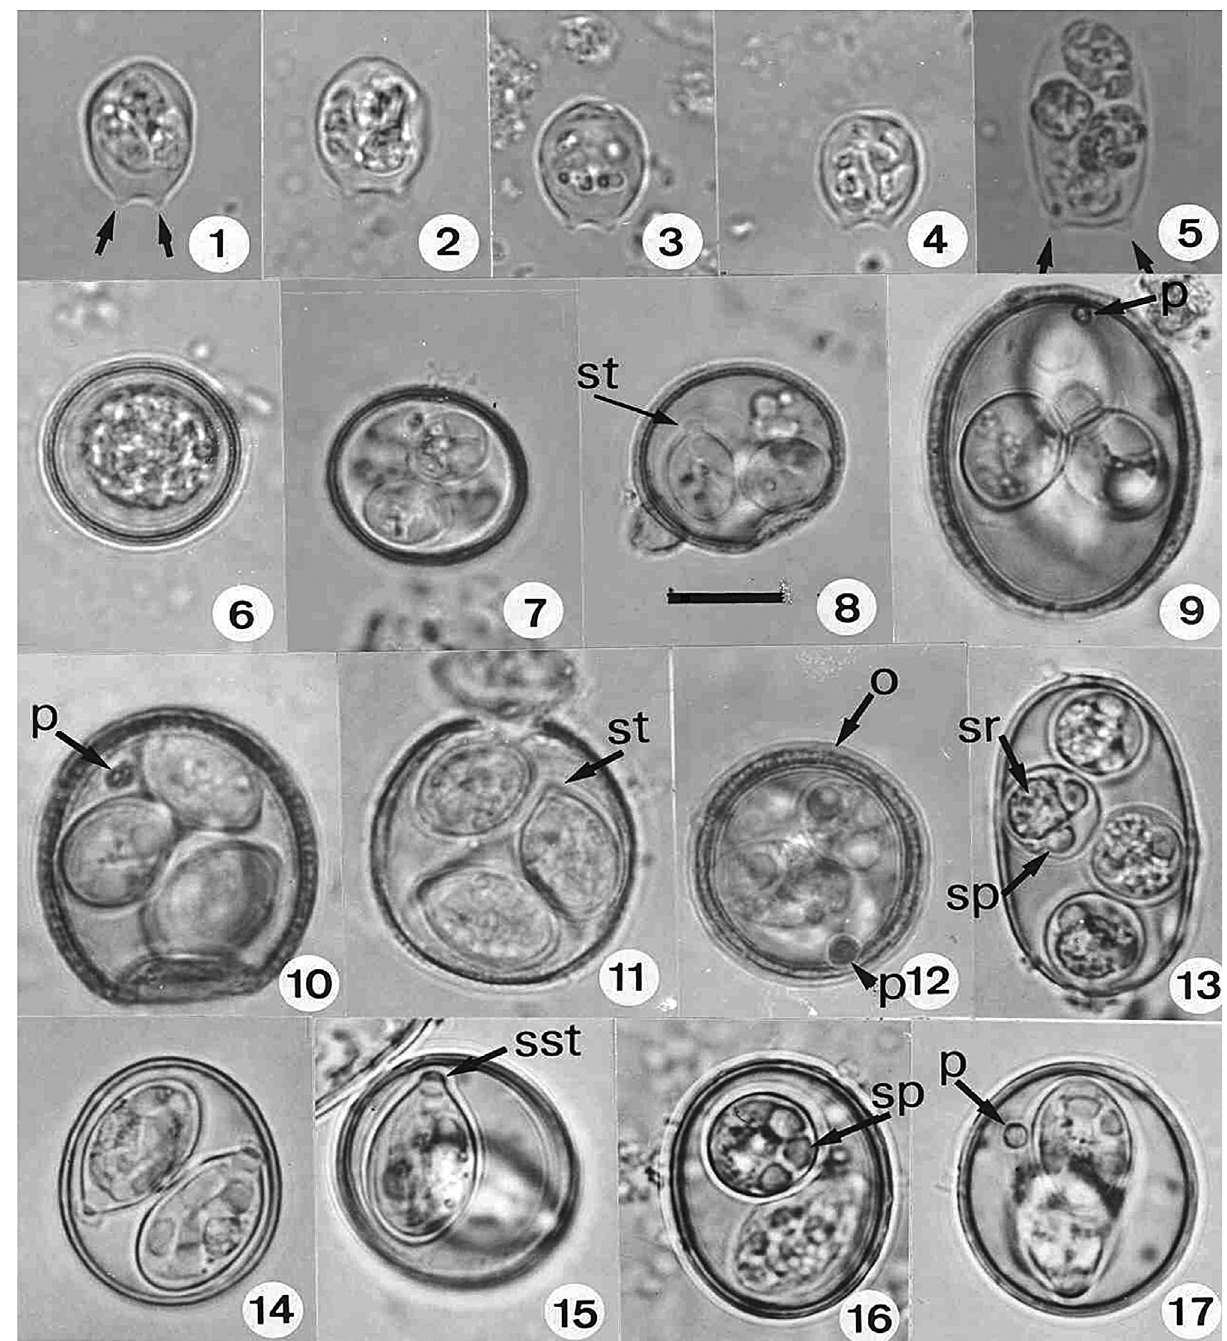
oocysts of E. carajasensis n. sp. from G. carbonaria : that in Figure 12 is an end-on view, showing the 2-layered, striated wall (o) to which a polar body (p) adheres. Fig 13. Eimeria wellcomei n. sp., also from G. carbonaria . Figs 14-17. Isospora rodriguesae n. sp. from G. den- ticulata . Bar in Figure 8 = 10 µm and applies to all other Figs. o = oocyst wall, p = polar body, st = Stieda body, sst = Stieda and sub- Stieda bodies, sp = sporozoite, sr = sporocystic residuum